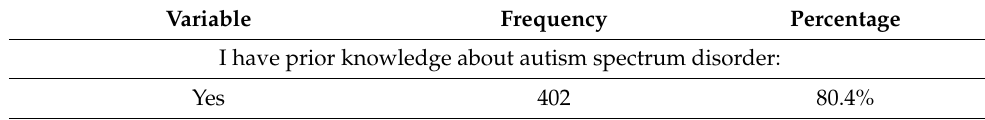
Table 2. Knowledge about autism spectrum